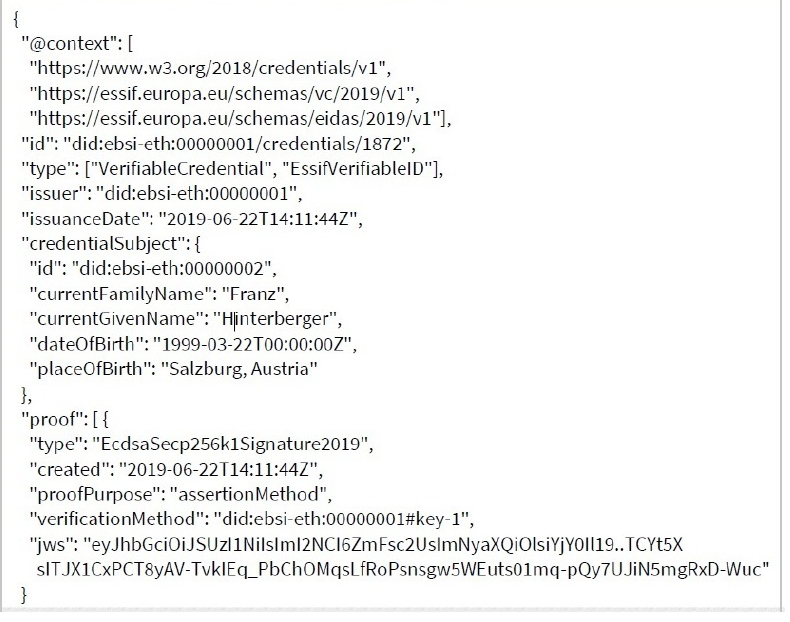
Figure 5. Format for Verifiable ID and Attestation signed with a DID